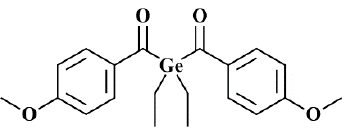
Figure 3. Chemical structure of the photo-initiator Ivocerin .